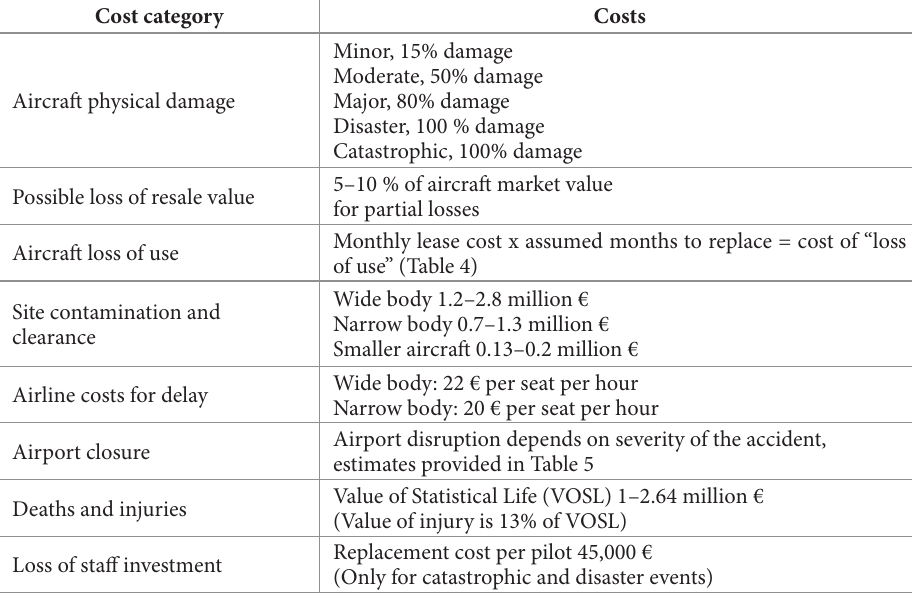
Table 8. Total accident related